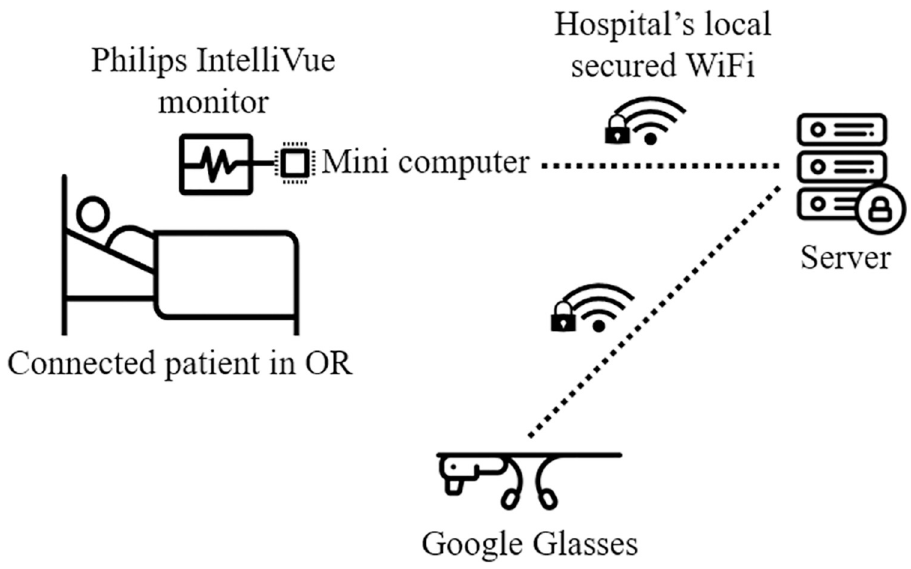
Fig 1. Overview of technical setup. (Some icons made by Freepik from www.flaticon.com).